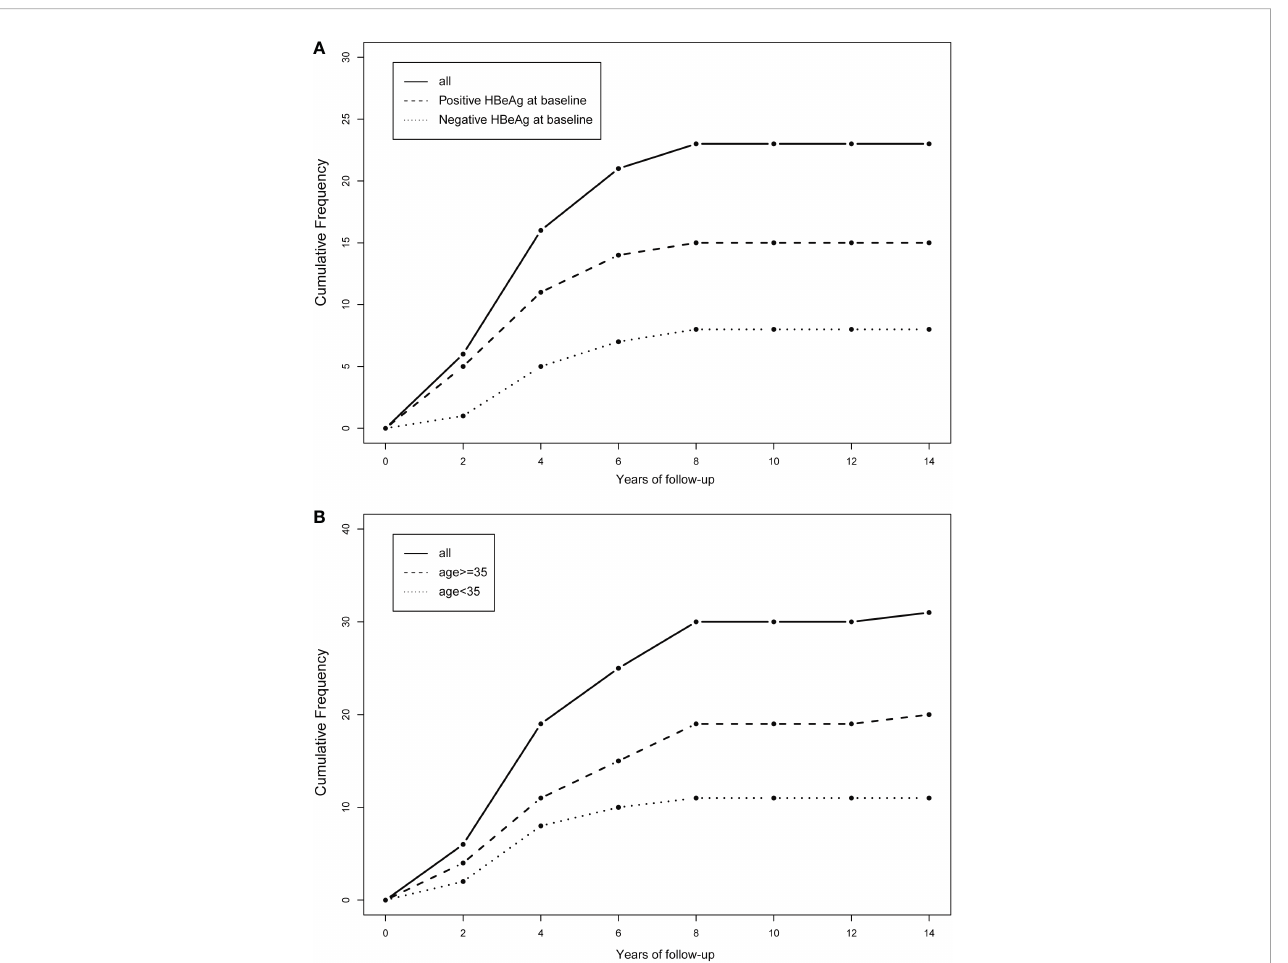
FIGURE 4 Cumulative frequency of HBsAg clearance strati fi ed by the baseline status of HBeAg and age. (A) Strati fi ed by the baseline status of HBeAg (positive HBeAg at baseline or negative HBeAg at baseline); (B) strati fi ed by age (age<35 or